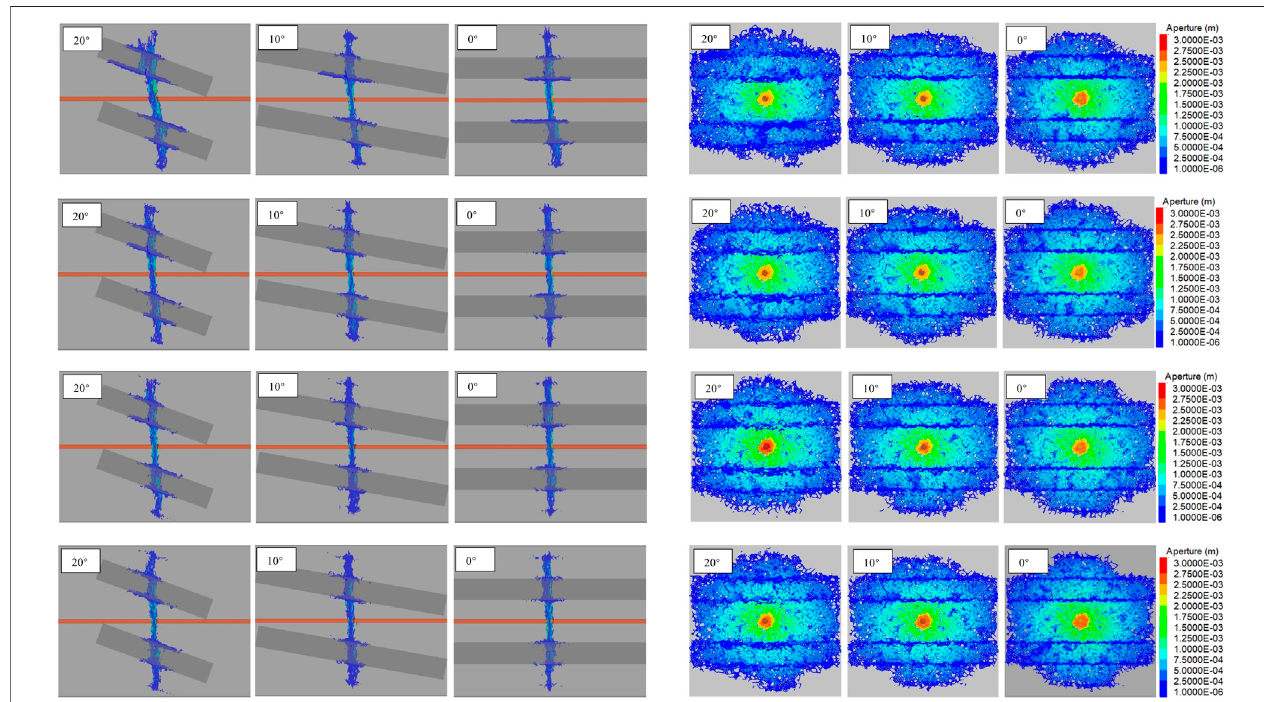
FIGURE 6 | Effects of caprock ’ s inclination and stress anisotropy on fracture propagation for vertical stresses of 8 MPa, 10 MPa, 12 MPa, and 14 MPa. (A) The model front view and (B) the model side view.